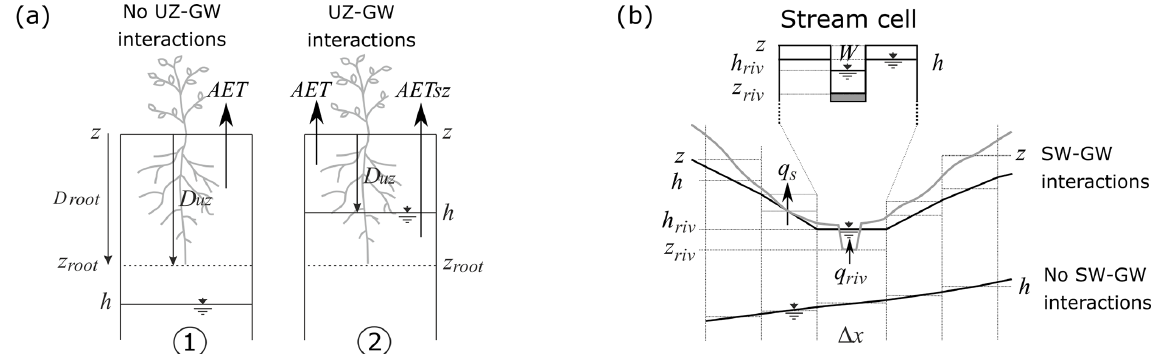
Figure 3. Schematic representation of (a) UZ–SZ interactions: (a1) indicates no UZ–SZ interaction, whereas (a2) indicates UZ–SZ inter- action (soil depth, D root , is reduced to D uz ). (b) surface water–groundwater (SW–GW) interactions in stream cells: boundary conditions change from no-flow to head-dependent flux conditions once the streambed or ground surface is intersected by the water table. The upper part of panel (b) shows the numerical implementation of SW–GW interactions in a stream